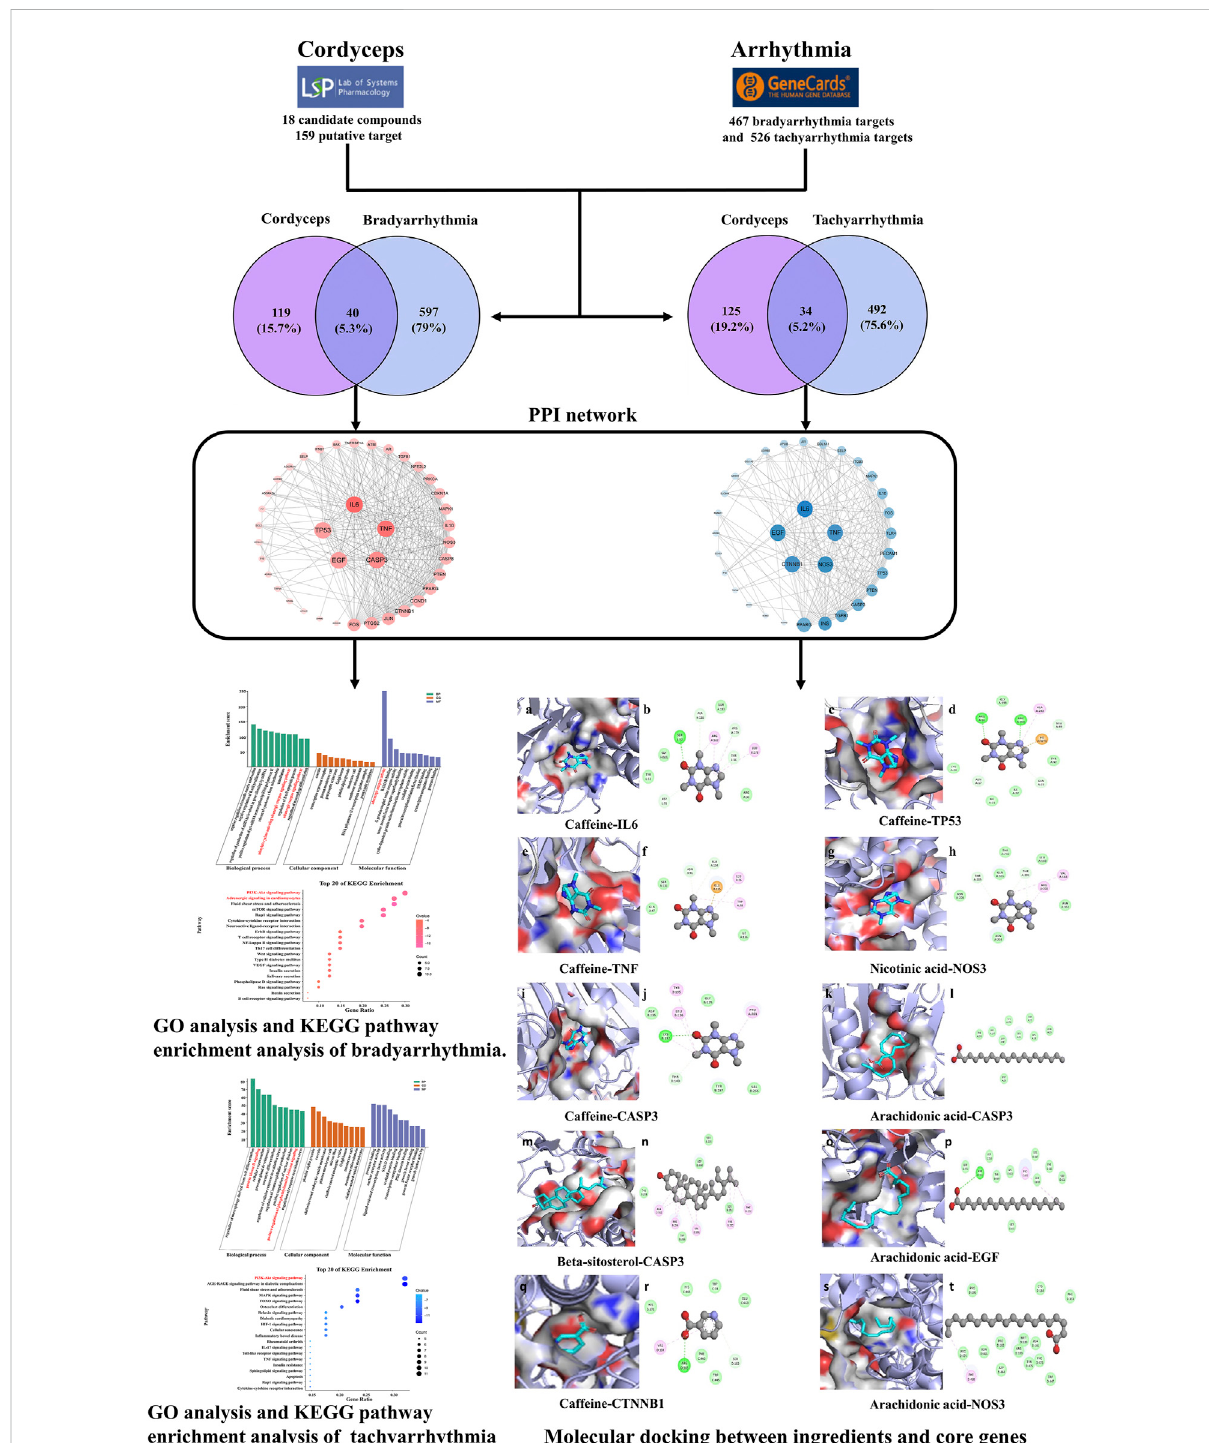
FIGURE 1 Flow chart investigating Cordyceps in the treatment of